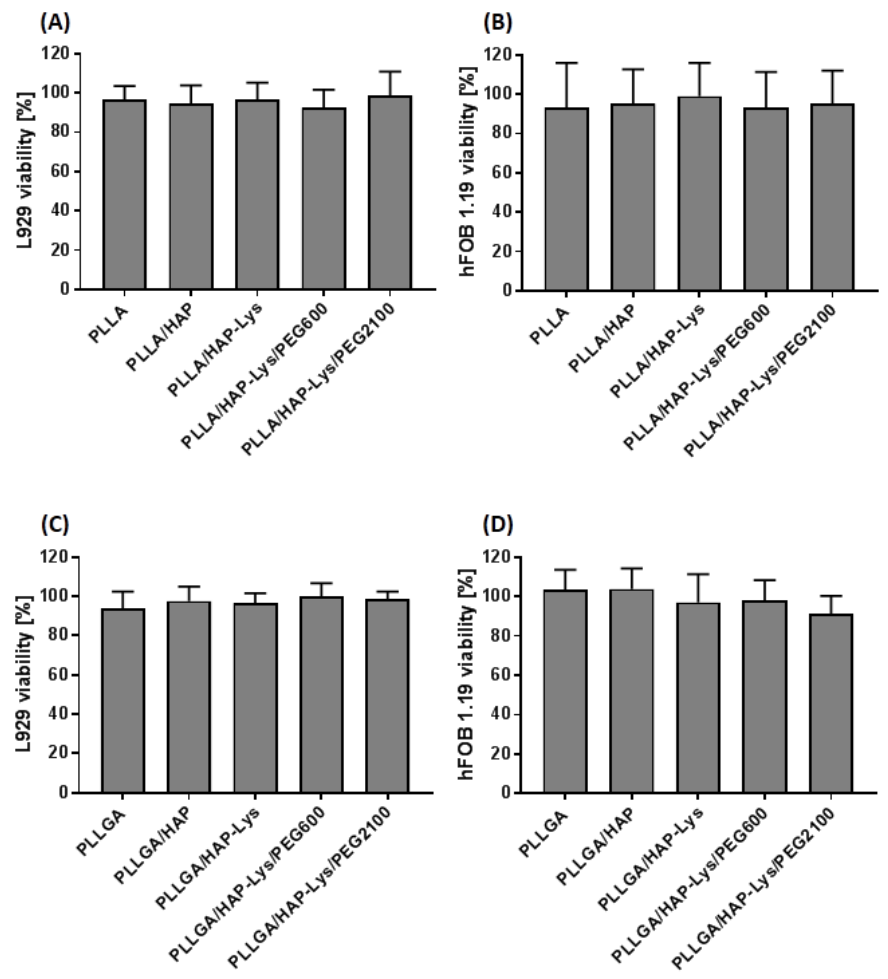
Figure 7. Viability of ( A , C ) murine fibroblasts L929 and ( B , D ) human osteoblasts hFOB 1.19, incubated for 24 h with ( A , B ) PLLA- or ( C , D ) PLLGA-based composites, evaluated using the 3-(4,5-dimethylthiazol-2-yl)-2,5-diphenyltetrazolium bromide (MTT) reduction assay according to ISO-10993-5:2009. The cells incubated without composites served as a positive control of viability (100%). Data are presented as mean ± SD of three separate experiments (six replicates for each assay ).